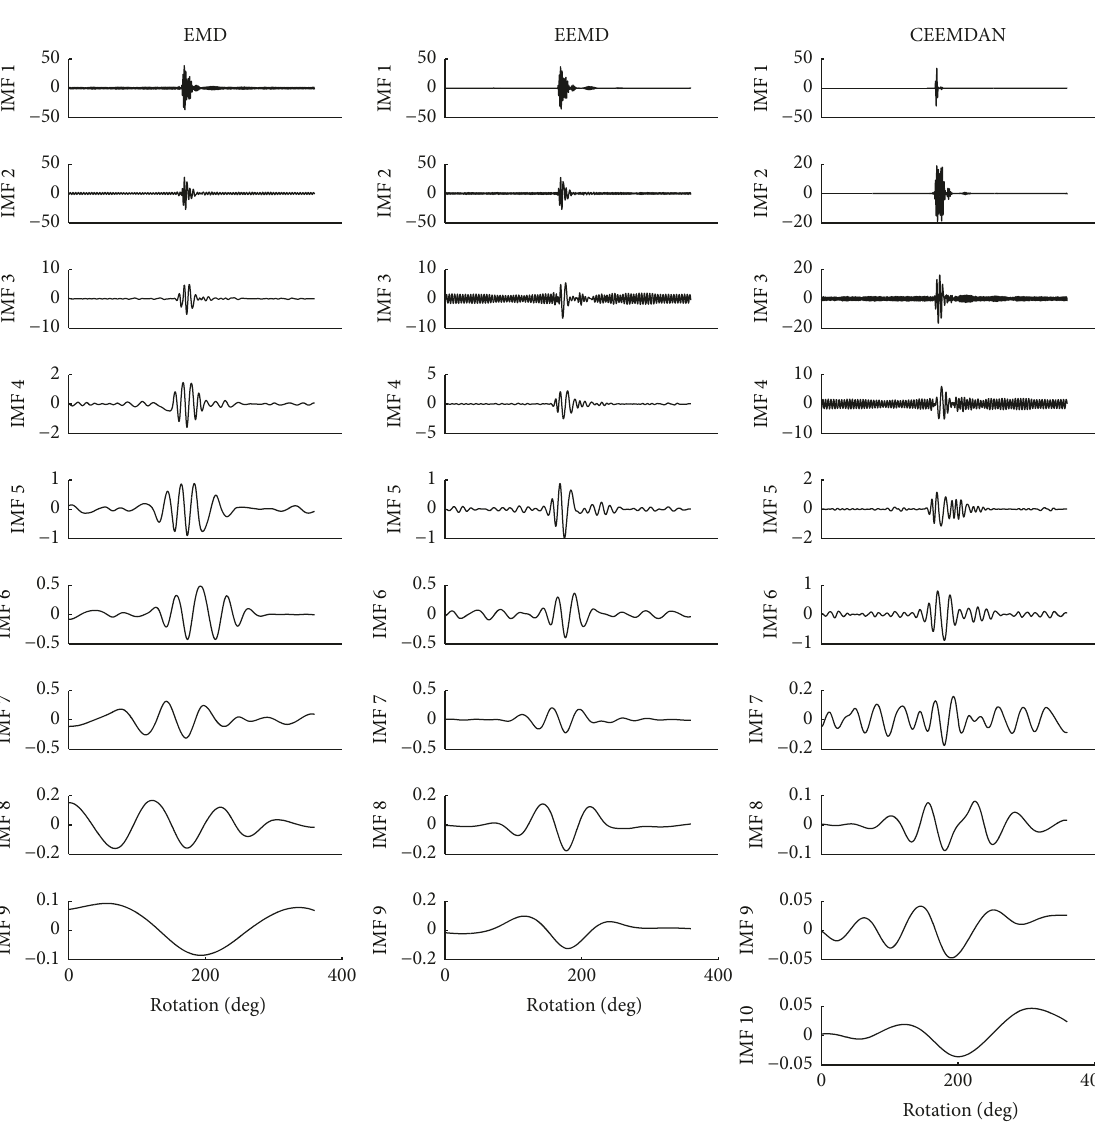
Figure 19: IMF sets of Case 2 obtained by using EMD, EEMD, and